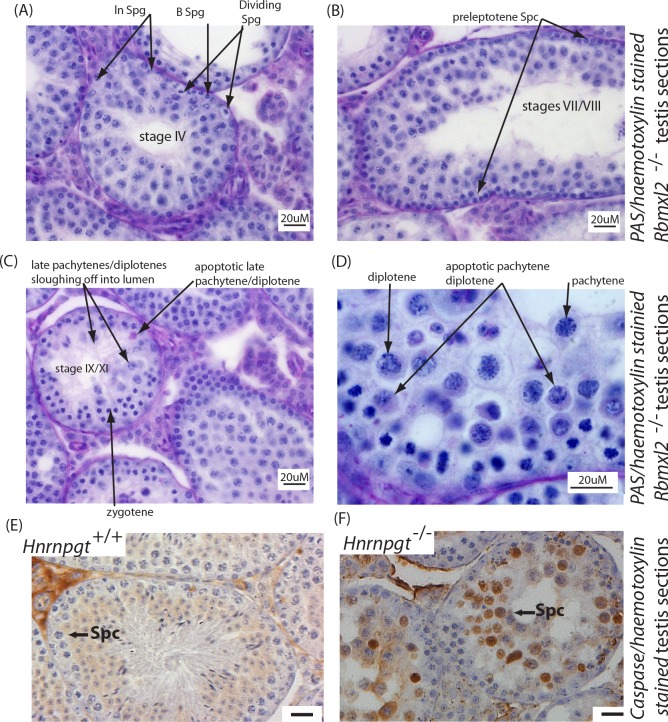
Detailed histological analysis of Rbmxl2-/- testes.(A) Section of Rbmxl2-/- testis including a stage IV Rbmxl2-/- seminiferous tubule. This stage IV tubule has no identifiable problems, and is identified by presence of dividing Ln spermatogonia and newly born B spermatogonia. (B) Stage VII/VIII tubule from Rbmxl2-/-mouse. In this tubule the pachytene cells still look normal, recognised by the presence of preleptotene spermatocytes (abbreviated Spc). (C) Stage IX-XI tubule from Rbmxl2-/-mouse showing zygotene cells, but rather few late pachytenes/diplotenes. These latter cells are disappearing because of sloughing off through the lumen and/or apoptosis. (D) Higher magnification image of stage IX-XI tubule from Rbmxl2-/- mouse, showing many apoptotic pachytene/diplotene cells, some of which are indicated by arrows. Wild type and Rbmxl2-/-testis sections were stained with Periodic Acid Schiff (PAS). Abbreviations: Spg, spermatogonia; Spc, spermatocyte. (E–F) Caspase three expression detected by immunohistochemistry on (E) wild type and (F) Rbmxl2-/- testes sections. Scale bar = 20 um.